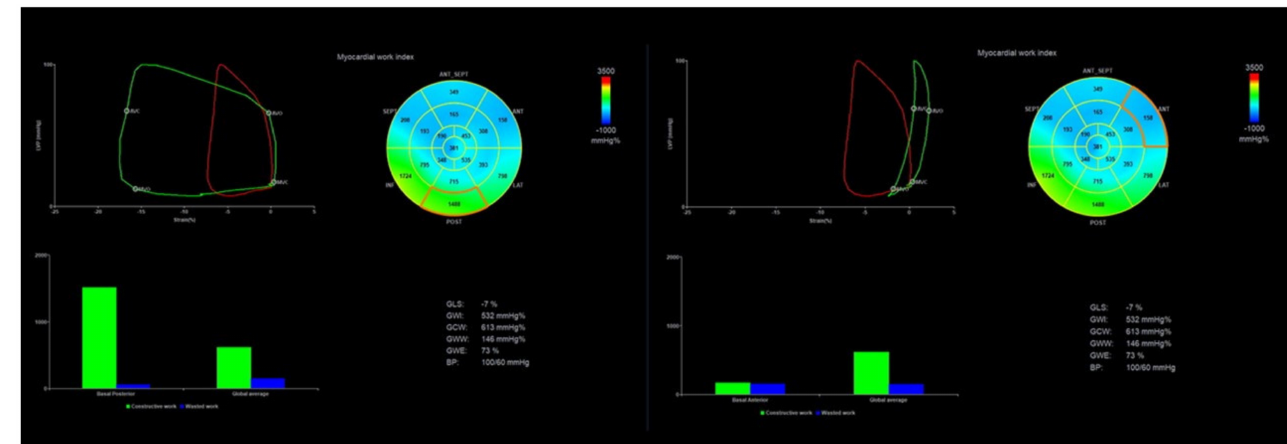
Figure 3. Patient with ischemic cardiomyopathy. Red loop is equal to the global MWI of the patient, while green loops show the PSL of a normal and abnormal segment of LV. GLS = − 7%, GWI = 532 mmHg%, GCW = 613 mmHg%, GWW = 146 mmHg%, GWE = 73%. Left green and blue bars of every screen represent the ratio of segmental constructive and wasted work, while bars at the right side represent their global values. You can appreciate the huge difference in the segmental values between the basal posterior segment ( left screen) and the basal anterior segment ( right screen) in a patient with extensive anterior myocardial infarction. The basal posterior creates a large pressure–strain loop and constructive work and contributes to ejection, while the basal anterior shows equal levels of constructive and wasted